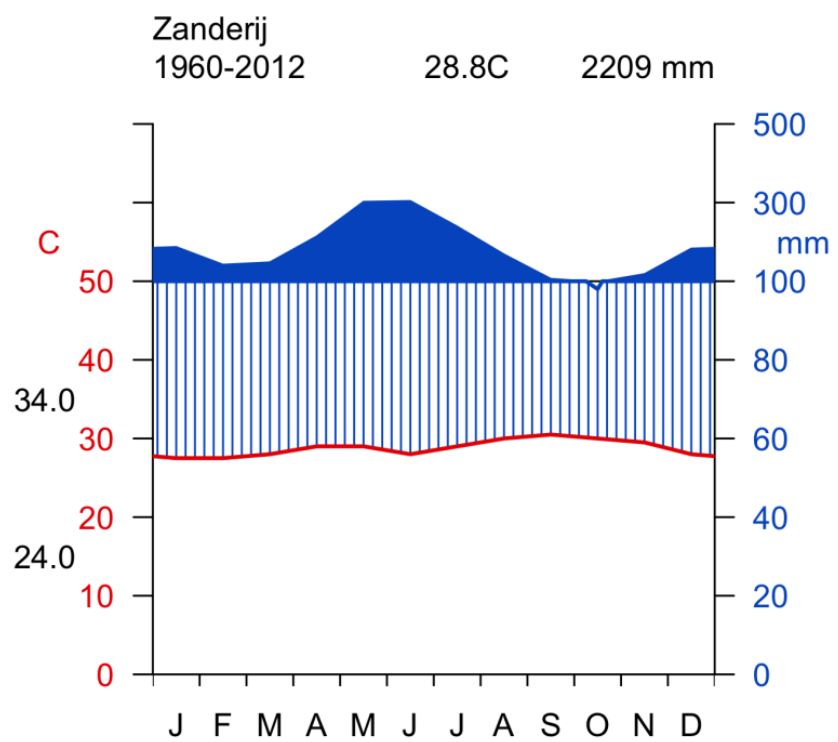
Figure 2. Walter–Lieth climate diagram for metrological station in Zanderij, Suriname. The precipita- tion and temperature data were measured from 1960 to 2012. The left y -axis shows the temperature ( ◦ C), while the right y -axis shows the precipitation (mm). The x -axis shows the months. The red curve shows the temperature, while the blue curve shows the precipitation. The climate diagram was created by the R package Climatol [47].